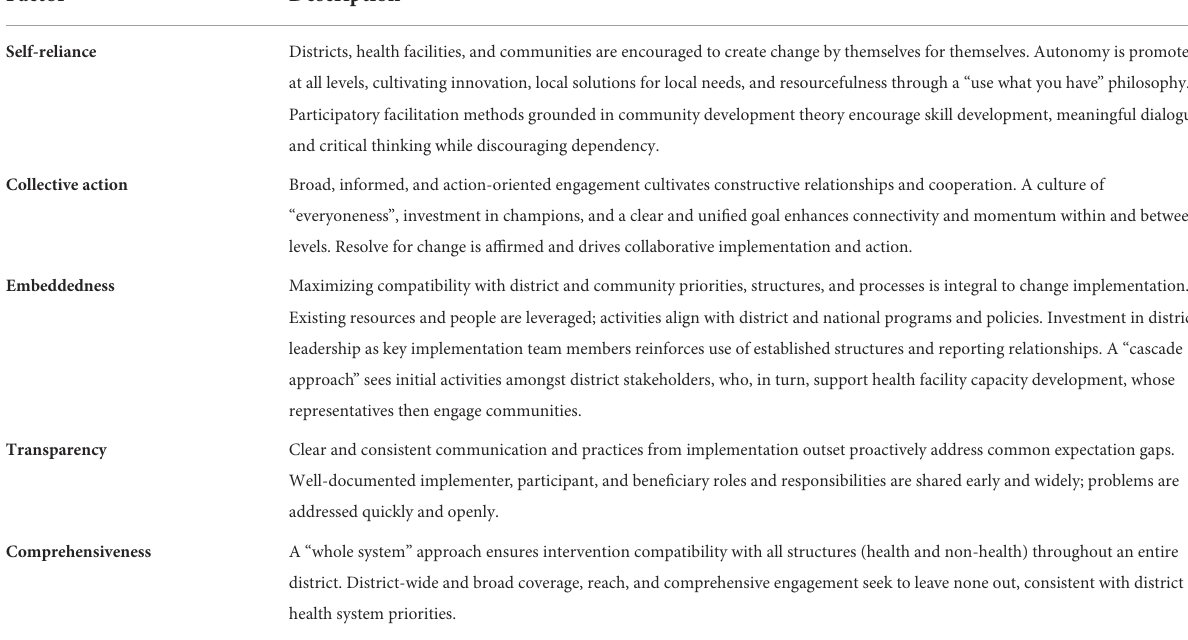
TABLE 4 Foundational factors in the MERI motivational framework.